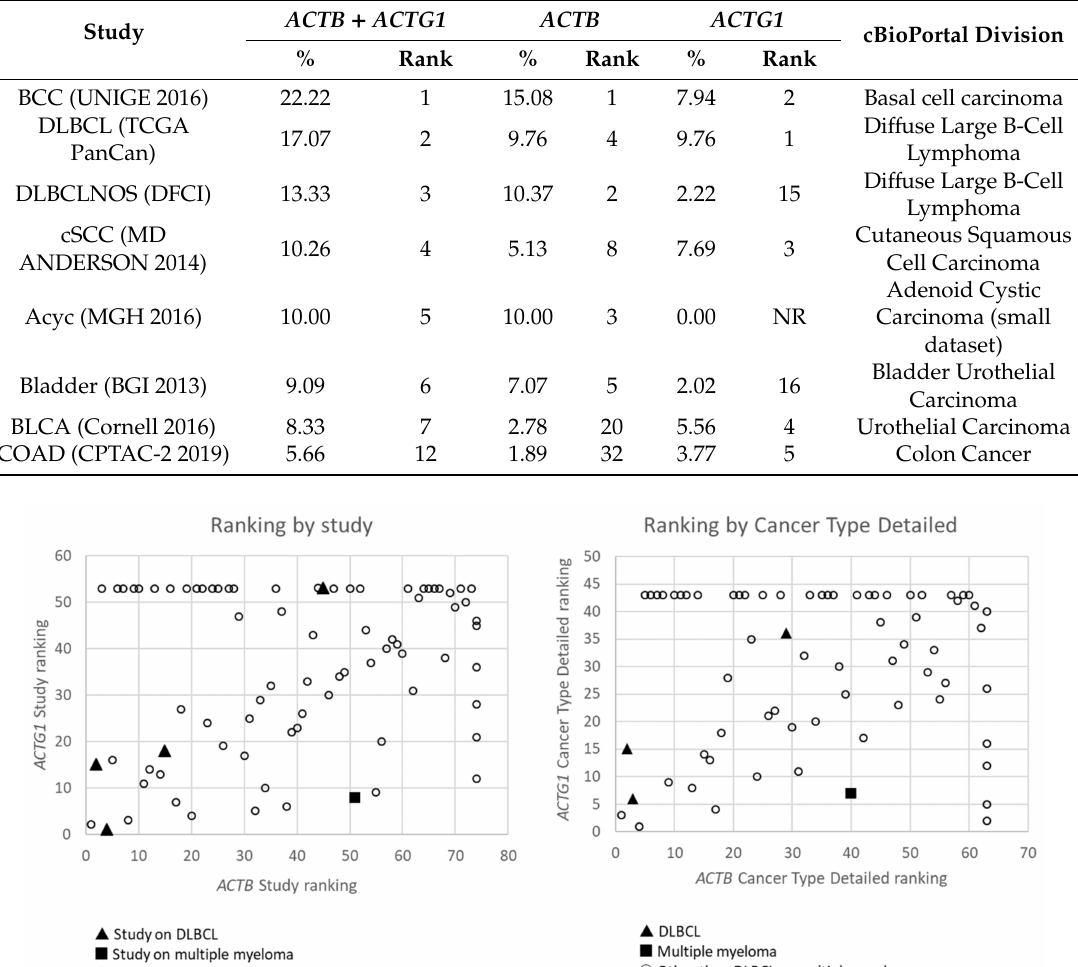
Table 2. Frequency of cases (altered / profiled patients, in %) displaying somatic mutations in ACTB and / or ACTG1 per study including the rank (out of 174) of these studies. For clarity only the top-ranking cancer studies are given; complete information is available at cBioportal. NR = not ranked. For full study names see Table S1. Data derived from the Cancer Types Summary tab.